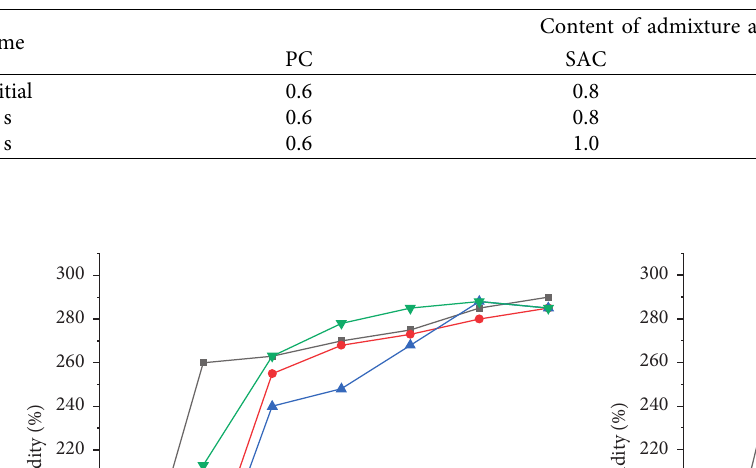
Table 8: The saturation point of four kinds of cementitious